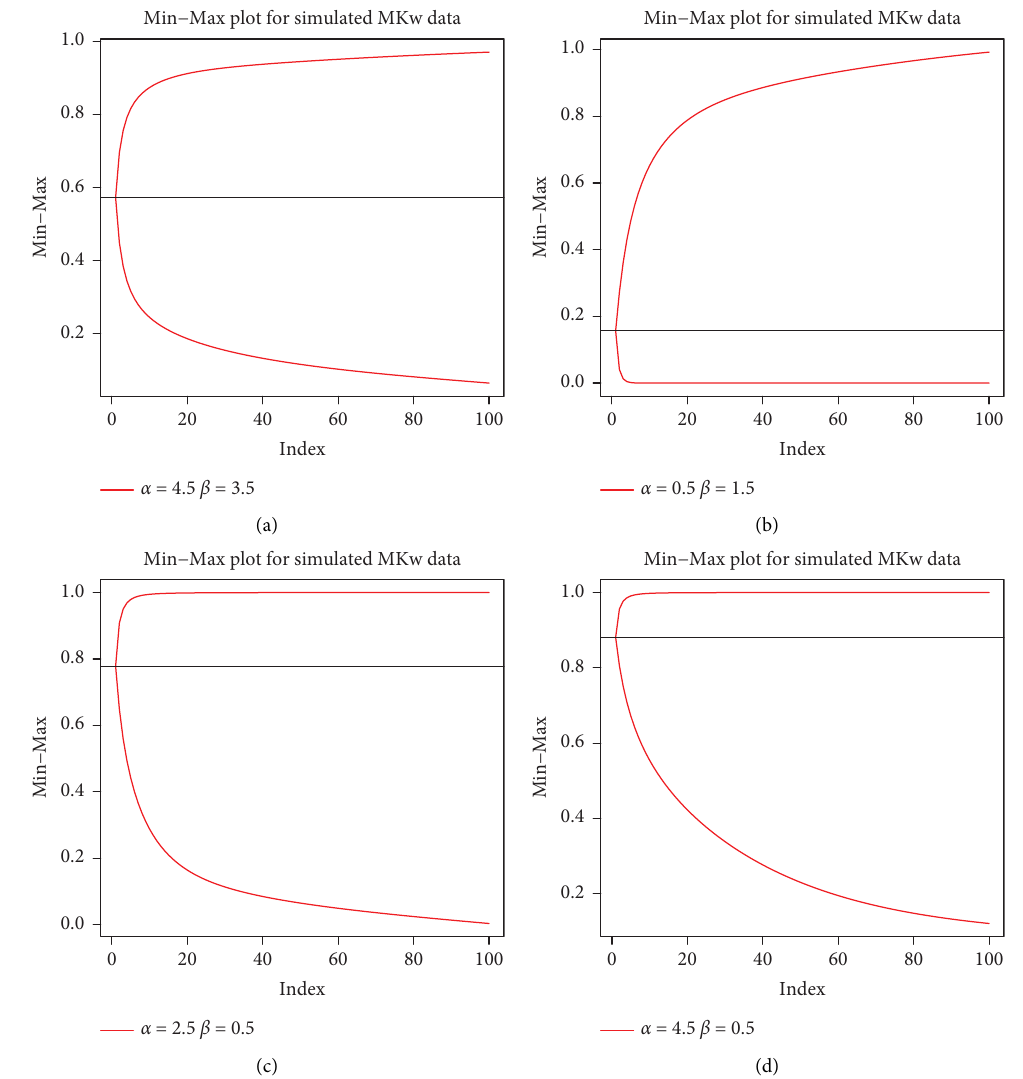
Figure 5: Min-max plot of order statistics of the MKw model for some parametric